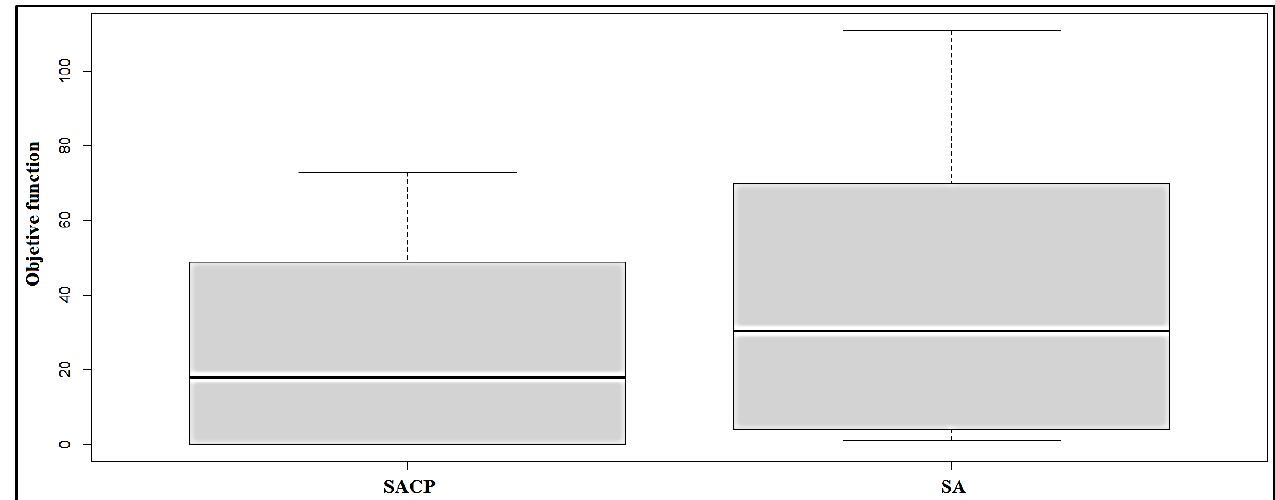
Figure 13. Boxplot of the SACP and SA algorithms.